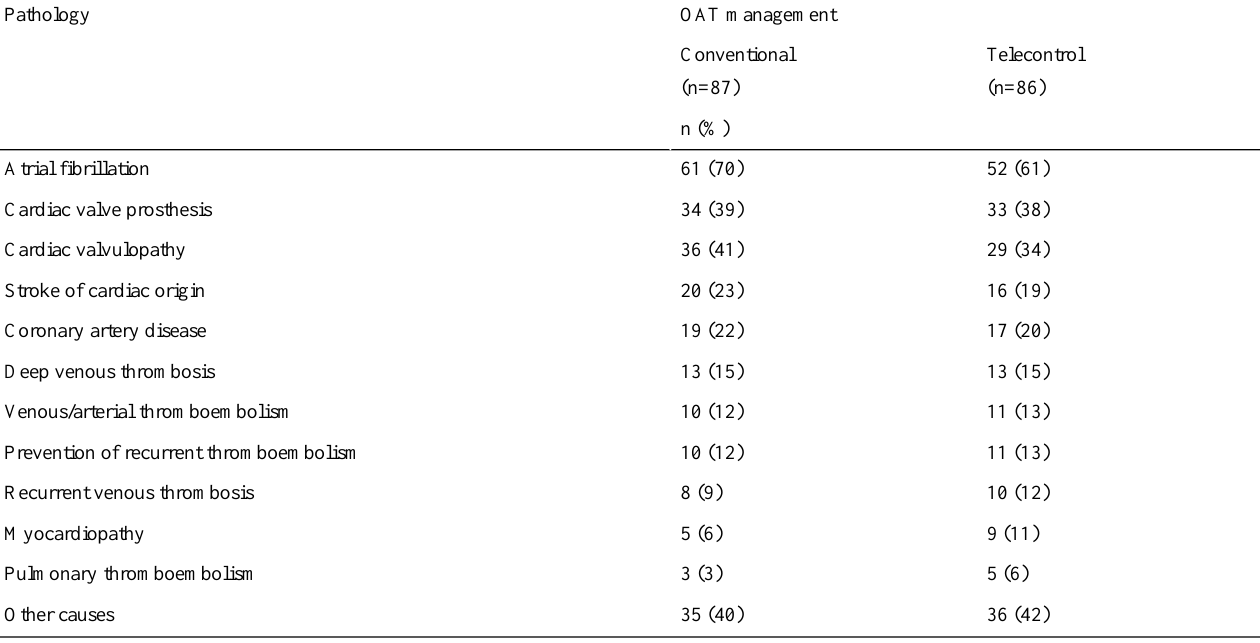
Table 2. Oral anticoagulant therapy (OAT)-requiring pathologies of patients in the two study groups (conventional control and telecontrol with the SintromacWeb system).